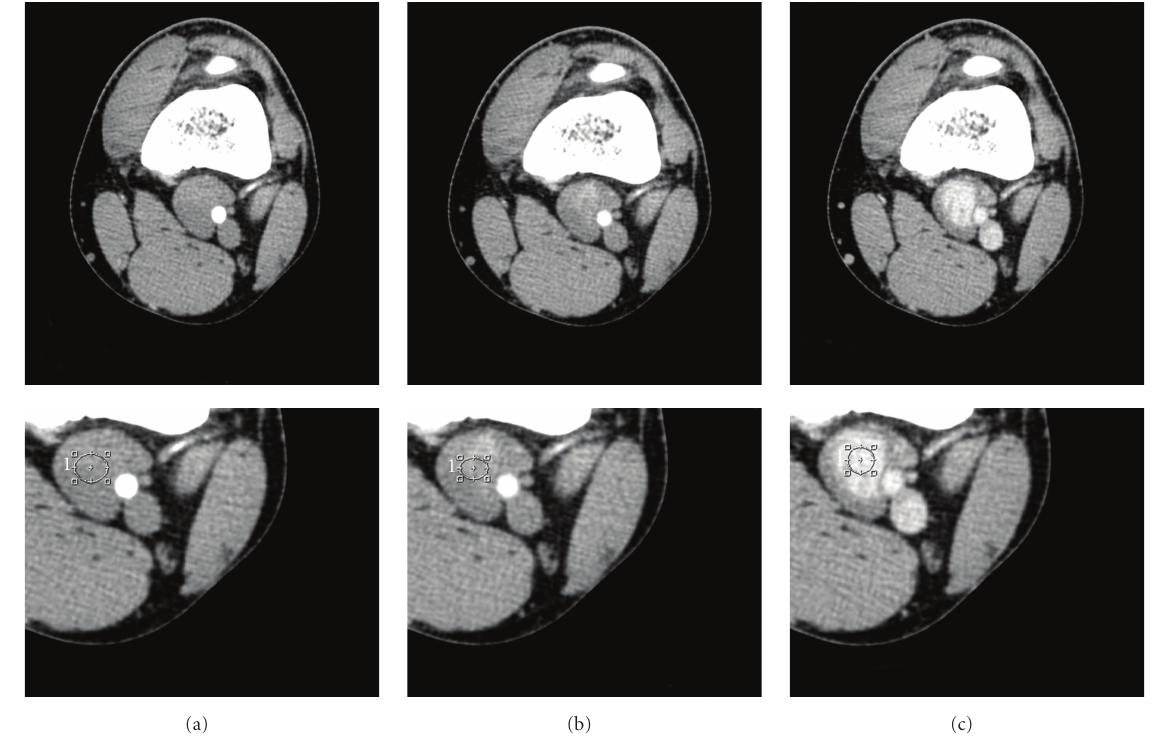
Figure 2: Angio-Computed Tomography (ACT) was obtained with three phases: arterious (a), venous (b), and delayed (c) from the injection of contrast media. The ACT acquisition confirmed a 36 mm × 17mm oval mass in the left popliteal fossa. This lesion presented contrast enhancement only in delayed acquisition (c) and so appeared to be a true venous aneurysm.